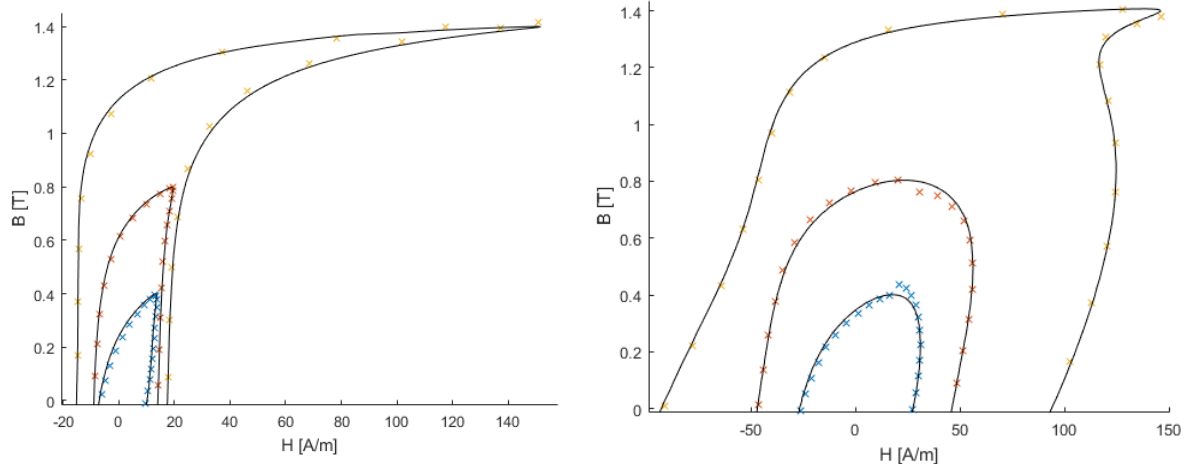
Figure 3. TEST 1: comparison between the simulated loops (colored cross markers) and the experimental ones (black continuous lines) with amplitudes of 0.4, 0.8, and 1.4 T, at frequencies of 5 Hz ( left panel) and 600 Hz ( right panel).